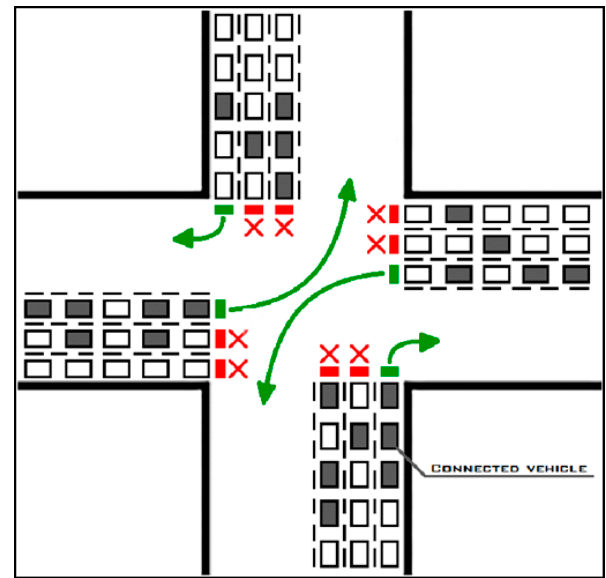
Figure 1. An example of signalized intersection, where, exact lane position information would be